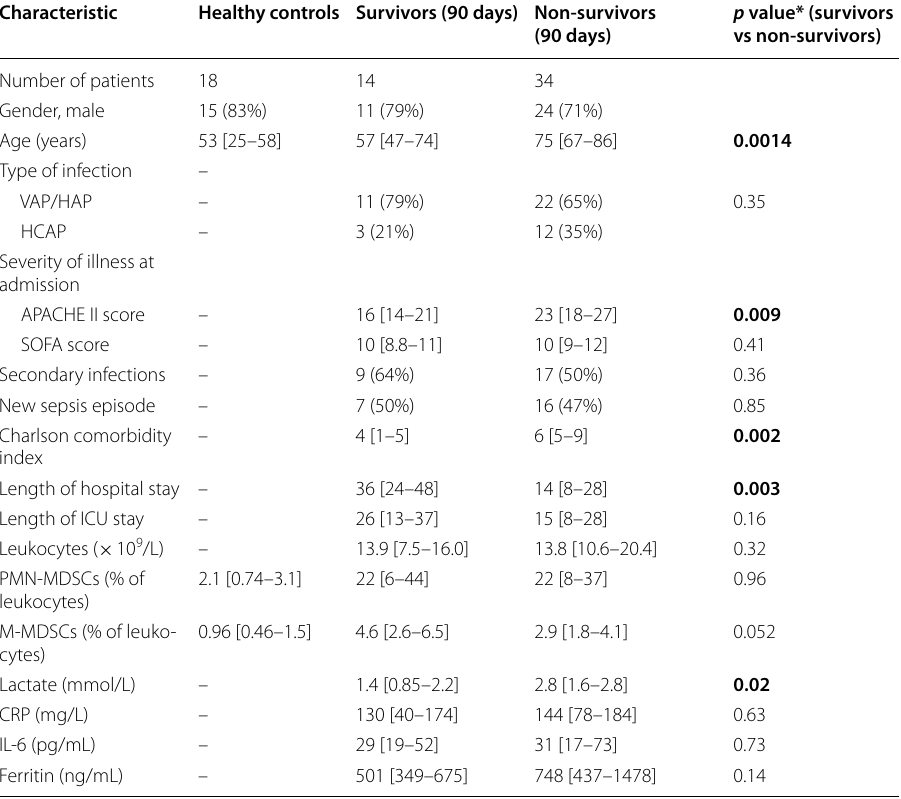
p values < 0.05 are highlighted in bold Data are medians [IQR] or n (%). Severity scores, leukocyte counts, MDSC levels and lactate levels were measured at study